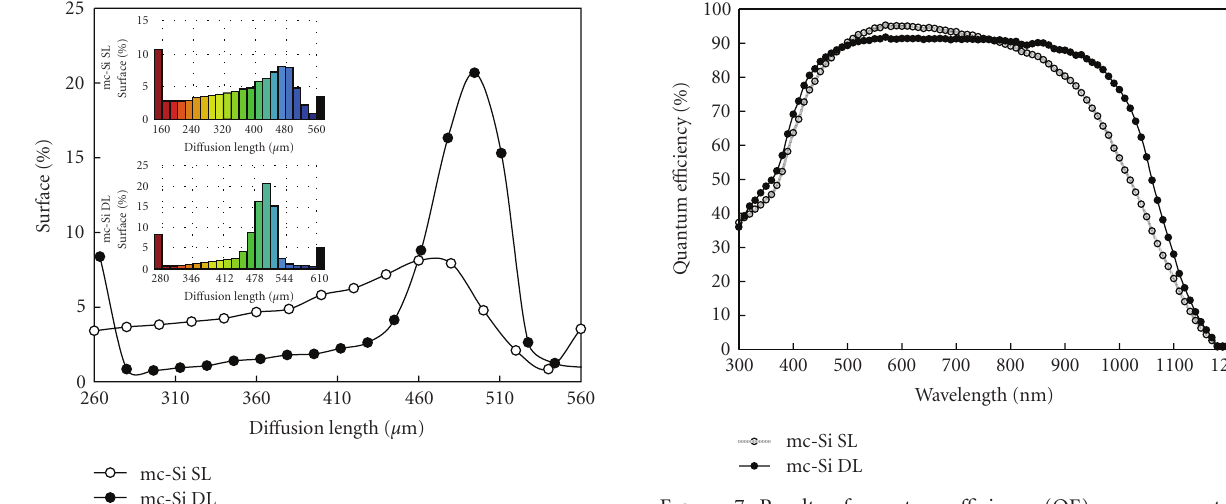
Figure 7: Results of quantum e ffi ciency (QE) measurements SL and DL coated on large size mc-Si solar cells. It clearly shows the DL coating with higher QE in a wavelength range of 450–1000 nm contributed to the lower reflection and the increase in e ff ective minority carrier di ff usion